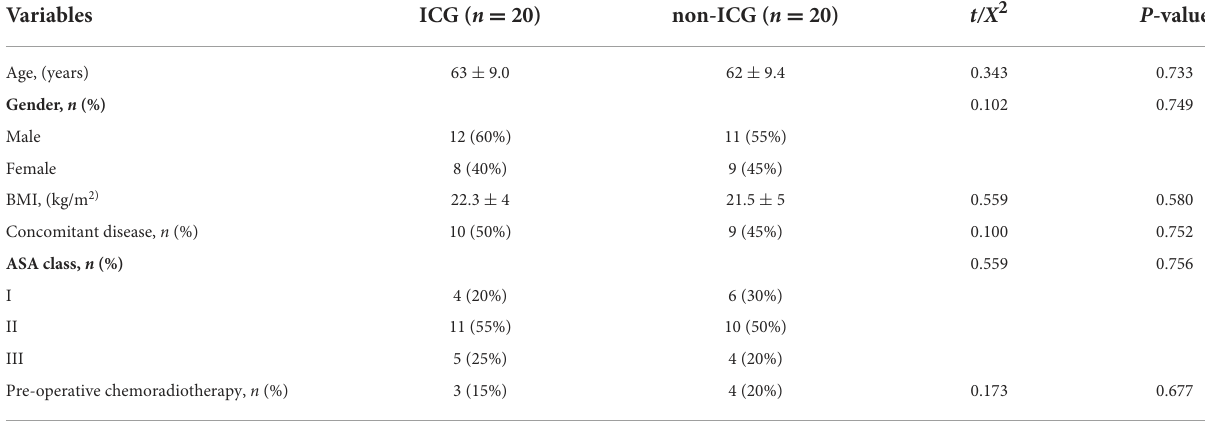
TABLE 1 Comparison of baseline characteristics.